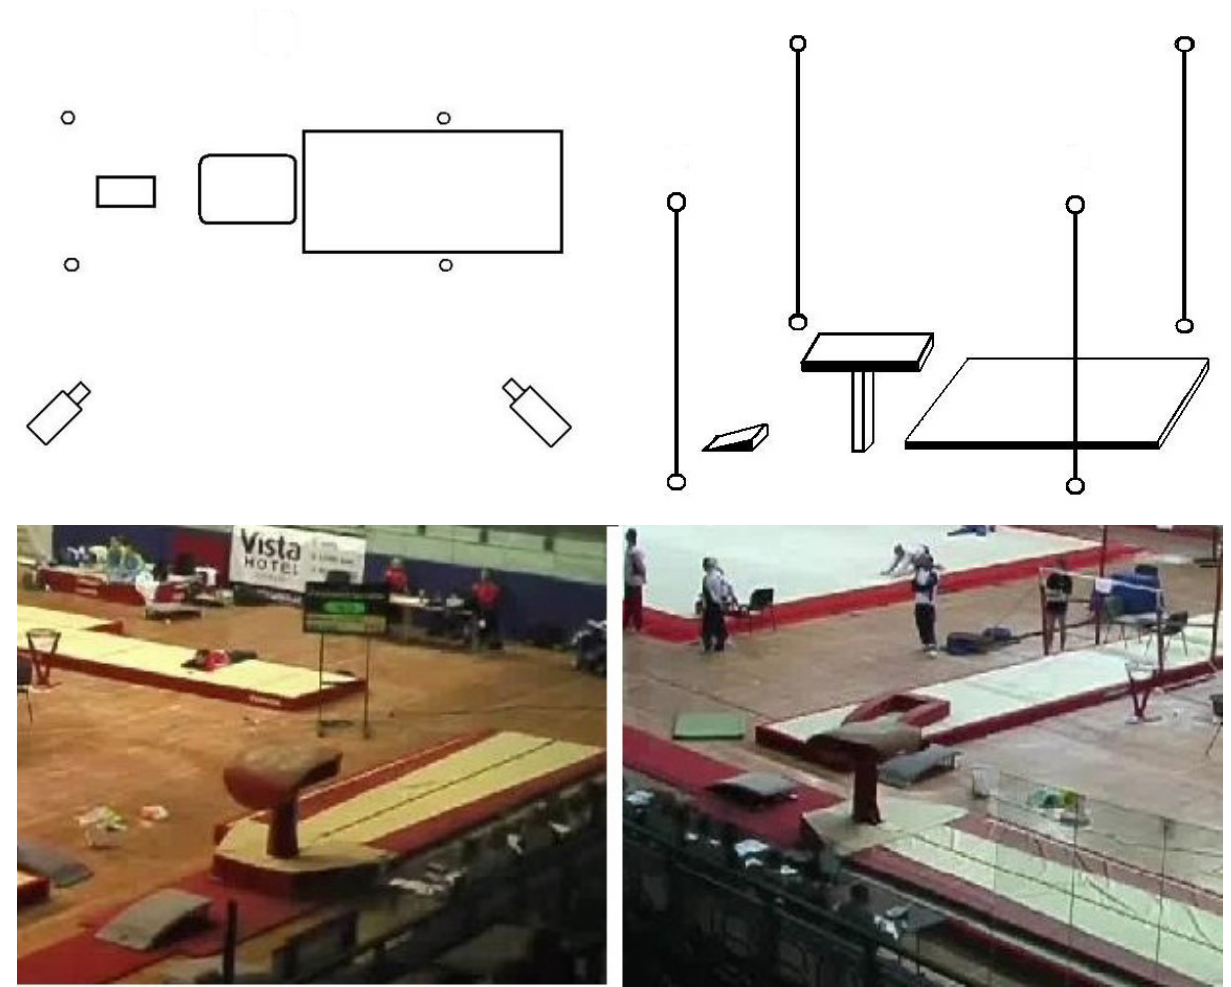
Figure 1. Calibration volume, camera set-up and vaulting